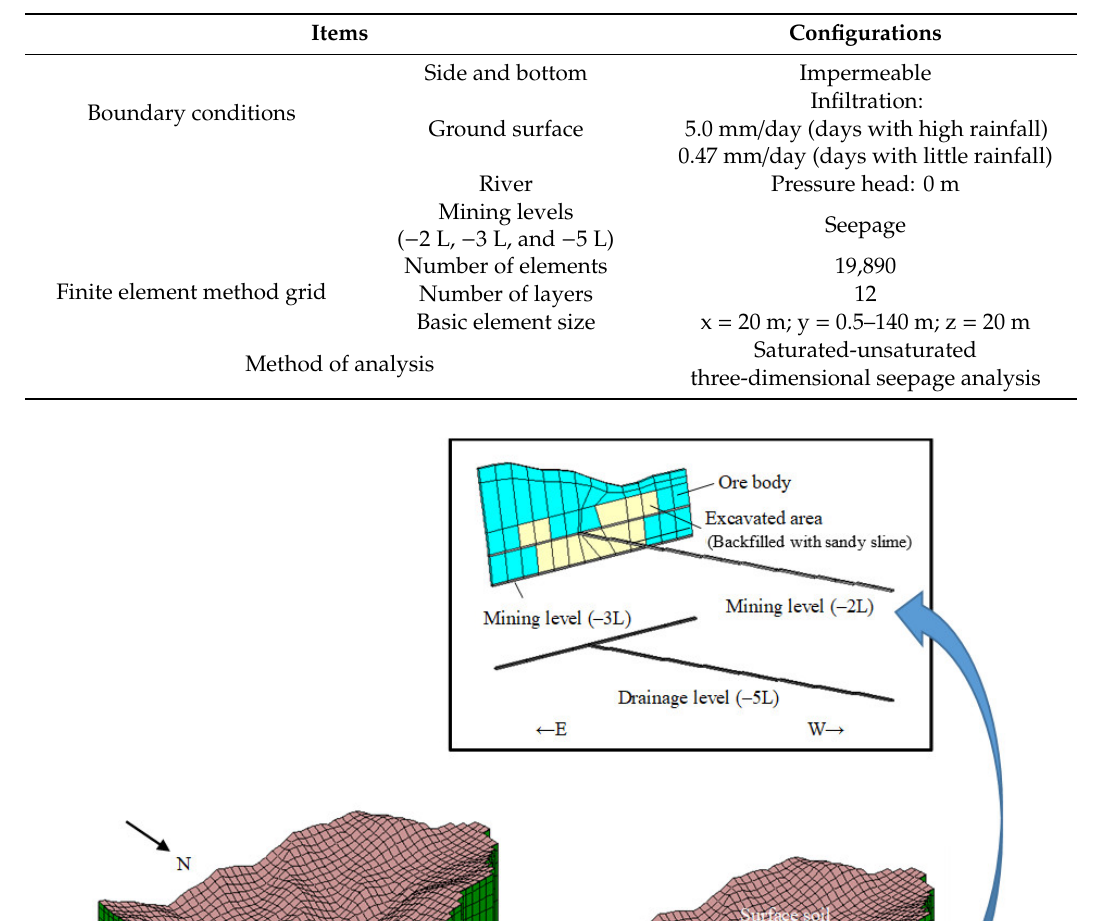
Table 1. Basic configuration of the numerical model.